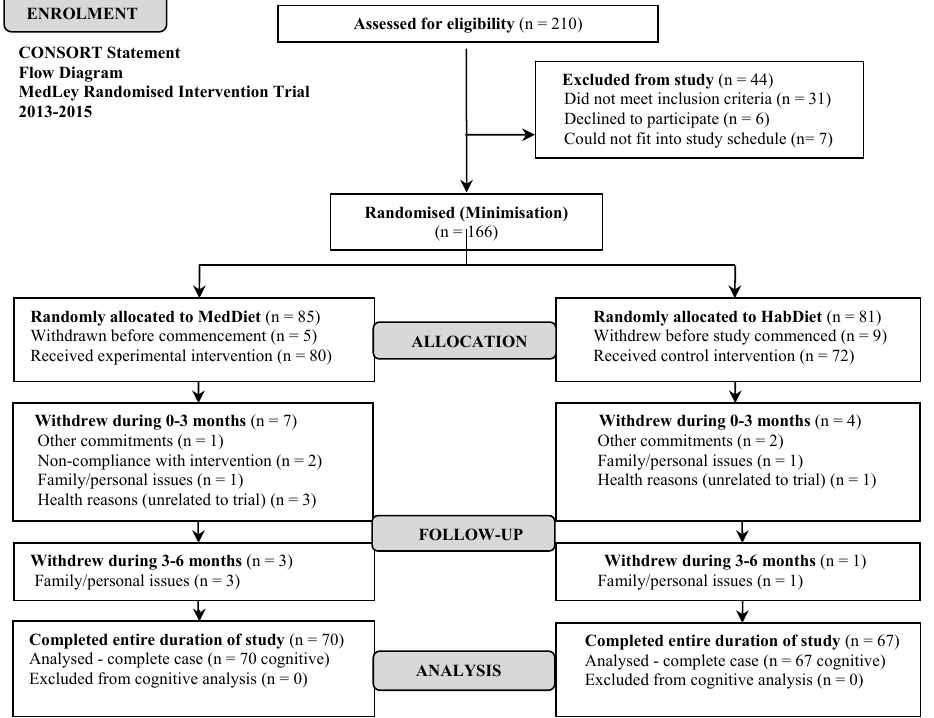
Figure 1. CONSORT flow chart from screening to completion (Knight et al., 2015) . Figure 1. Consolidated Standards of Reporting Trials (CONSORT) flow chart from screening to completion